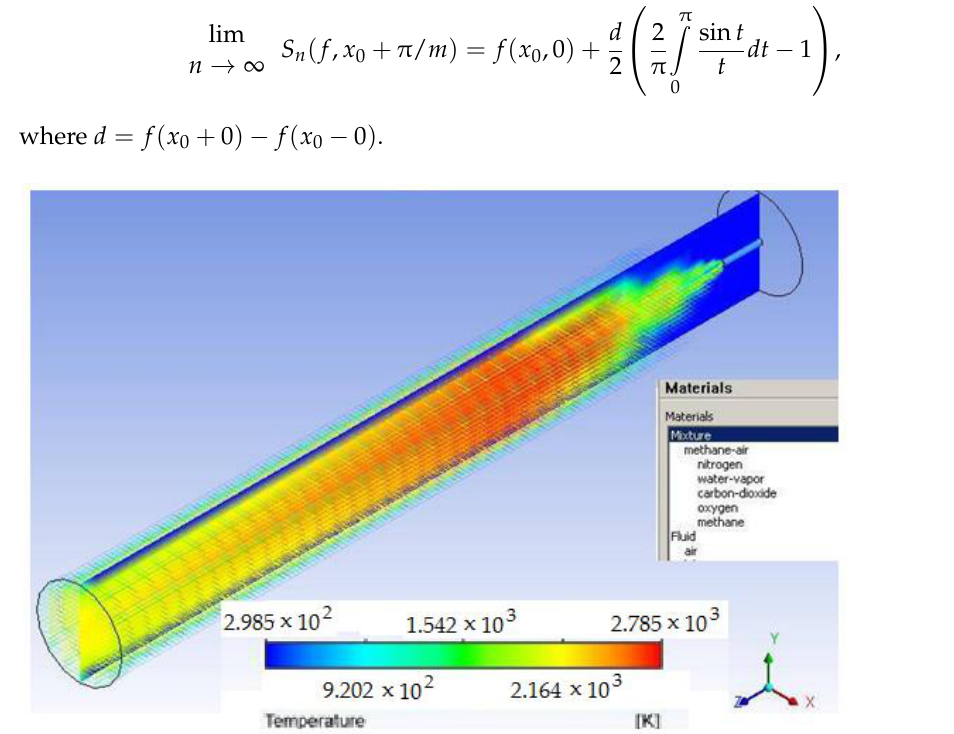
Figure 7. Physical modeling of the process of natural gas and air mixture outflow from the burner nozzle (according to the authors’ data).